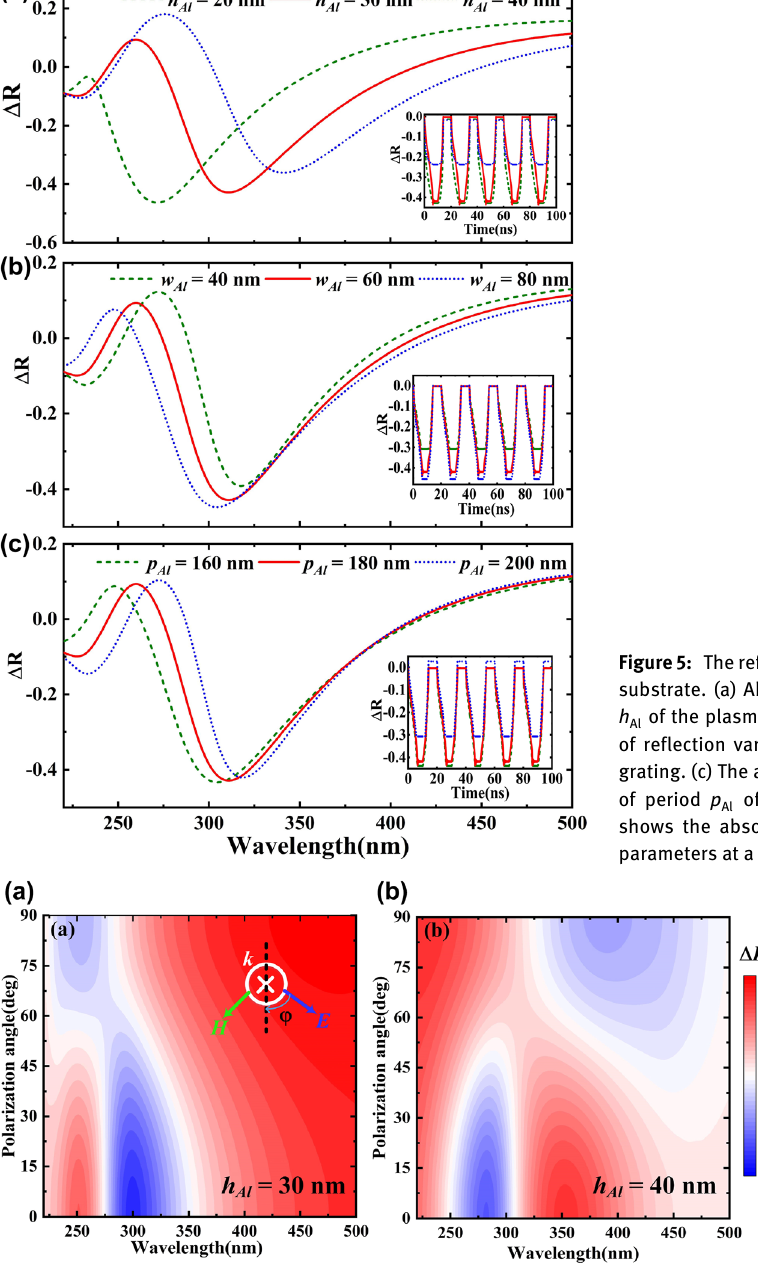
= 30 nm, (b) h = 40 nm. Al Al